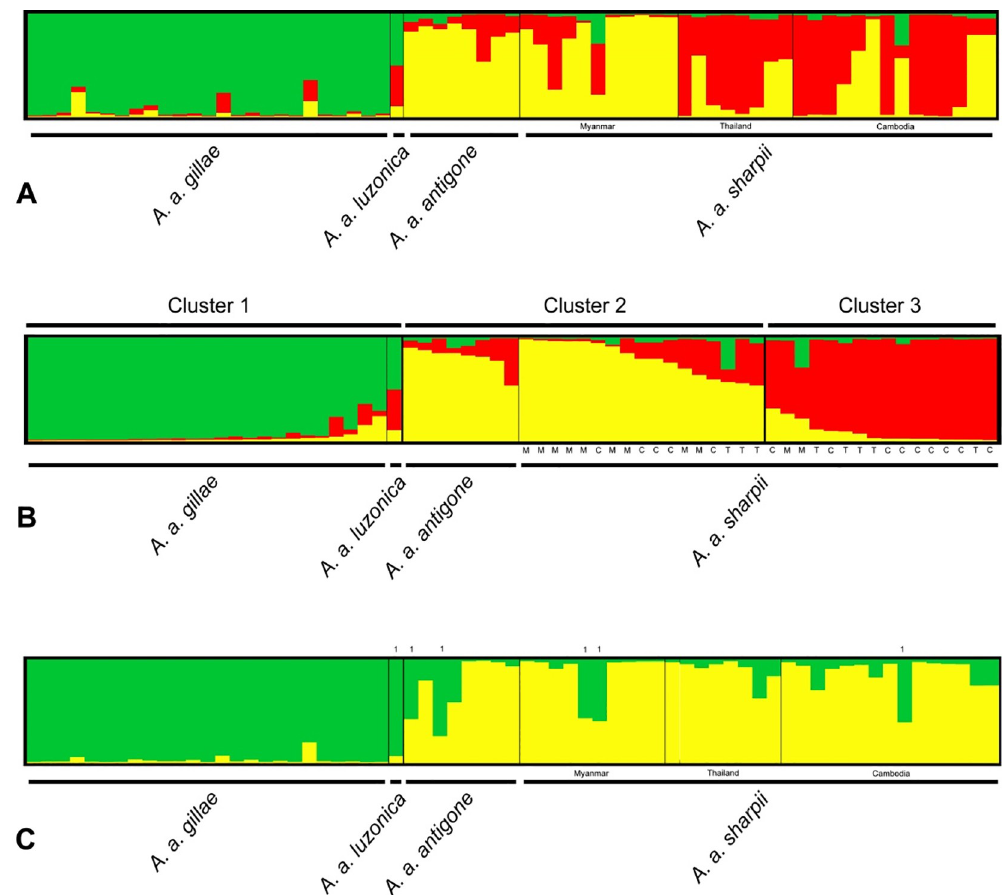
Fig 3. Bayesian cluster analyses of microsatellite data (STRUCTURE/CLUMPAK). A, B: assuming admixture and correlated allele frequencies, K = 3; y axis, membership coefficient from 0 (bottom) to 100 (top); in A, individuals are sorted by subspecies and country of origin; in B, samples are ordered by cluster, subspecies within clusters and membership coefficient Q (y-axis). For A . a . sharpii , the country of origin is indicated by the first letter (C = Cambodia, M = Myanmar, T = Thailand). C: assuming admixture and independent allele frequencies, K = 2; samples ordered by subspecies and country of origin within A . a . sharpii . Cluster 1 consists of all A . a . gillae as well as specimens labelled with